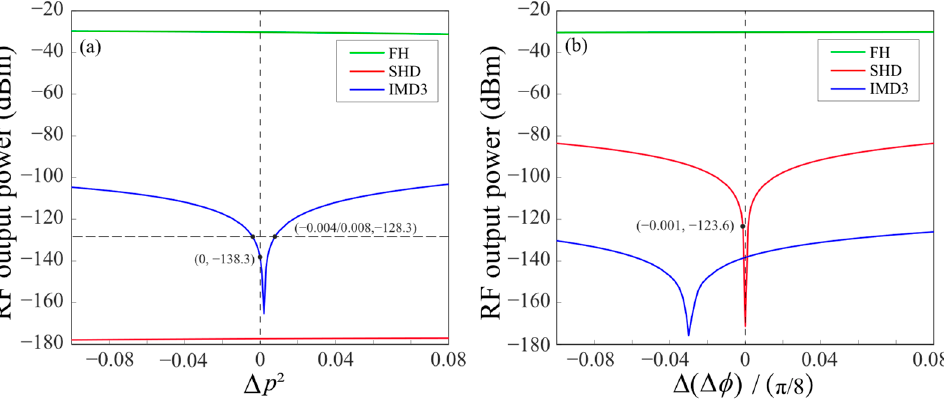
Figure 7. Tolerance of the CS-AMZM with the deviation of ( a ) p 2 and ( b ) Δ ϕ .